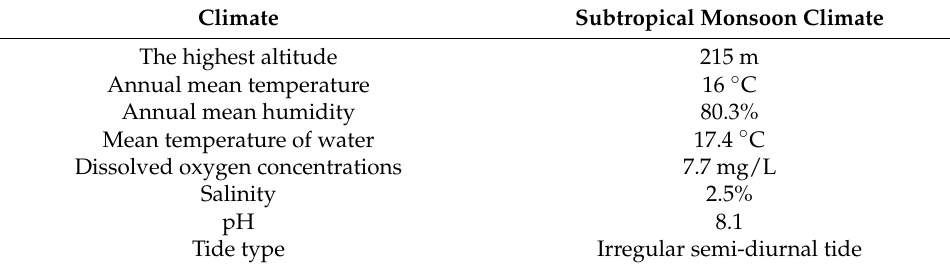
Figure 2. ( a ) Marine tidal zone in Zhairuoshan island. ( b ) Detail of the placed concrete samples. Table 3. Atmospheric and water environment of Zhairuoshan Island.